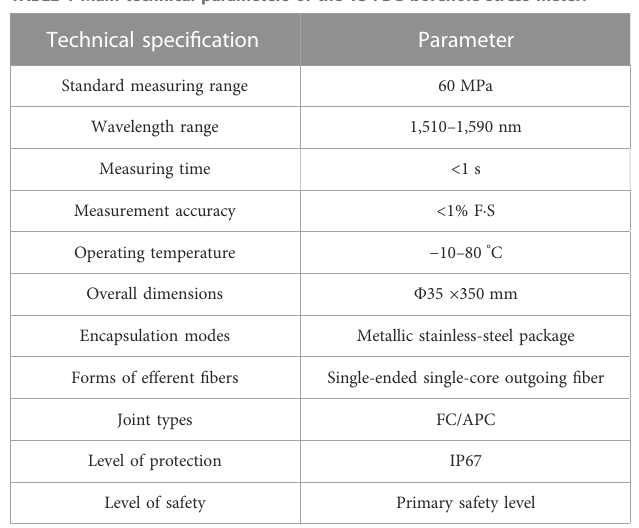
TABLE 1 Main technical parameters of the TS-FBG borehole stress meter.